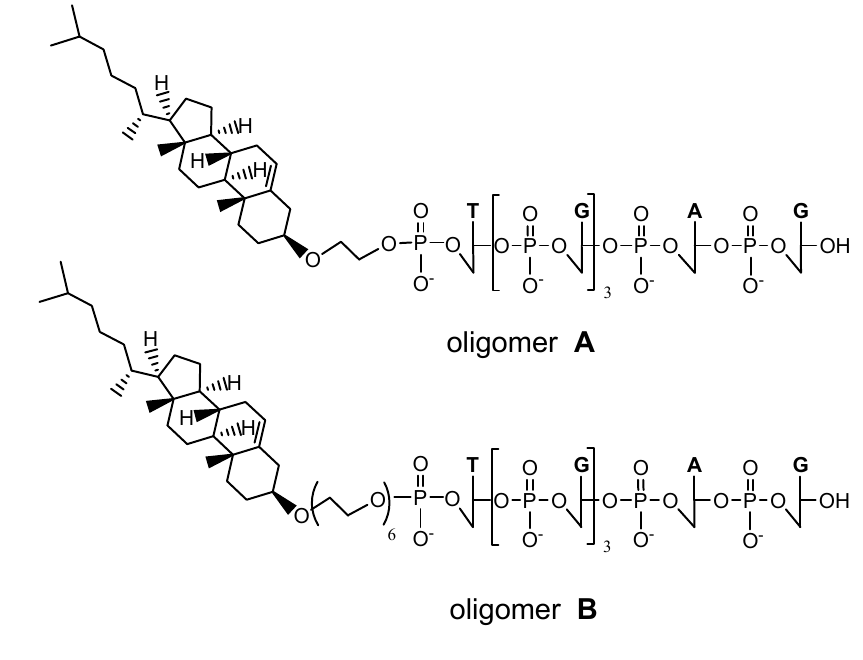
Figure 3. Chemical structure of the 5'-cholesteryl conjugates of Hotoda’s sequence A and B